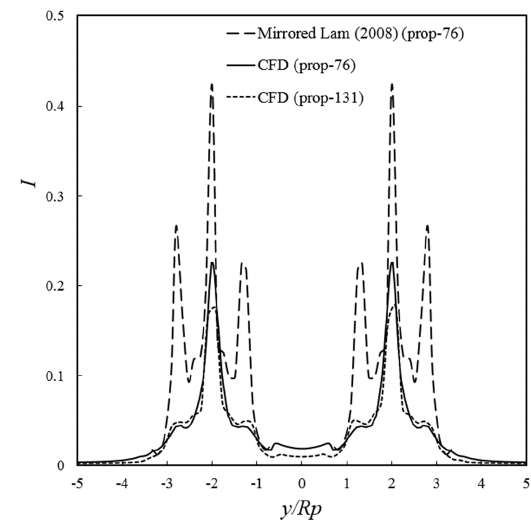
Figure 15. Turbulence intensity distributions at efflux plane.